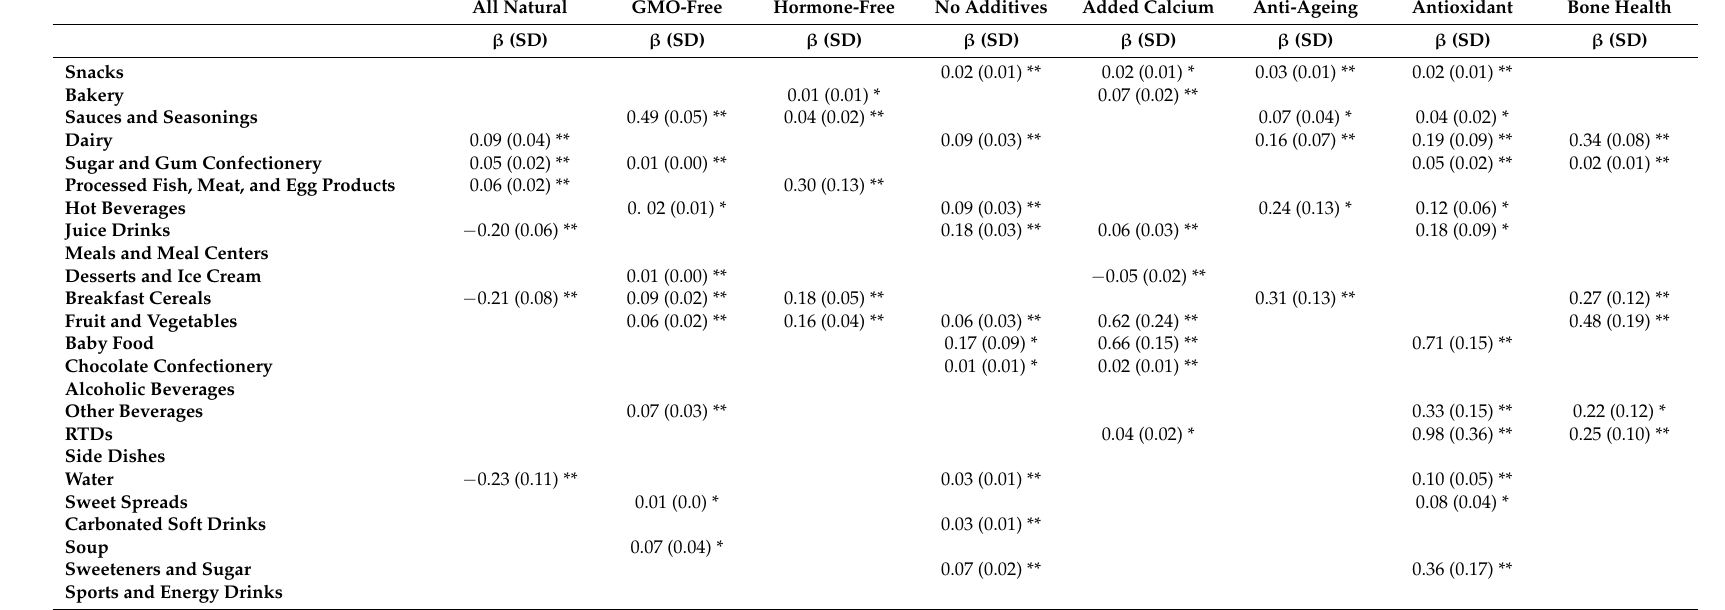
Table 3. Results of trend regressions on location quotient of products with health, nutrition, and food safety claims by product